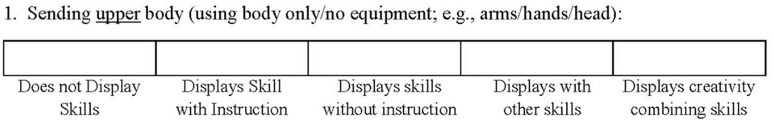
Example item rating scale from Pre-PLAy.